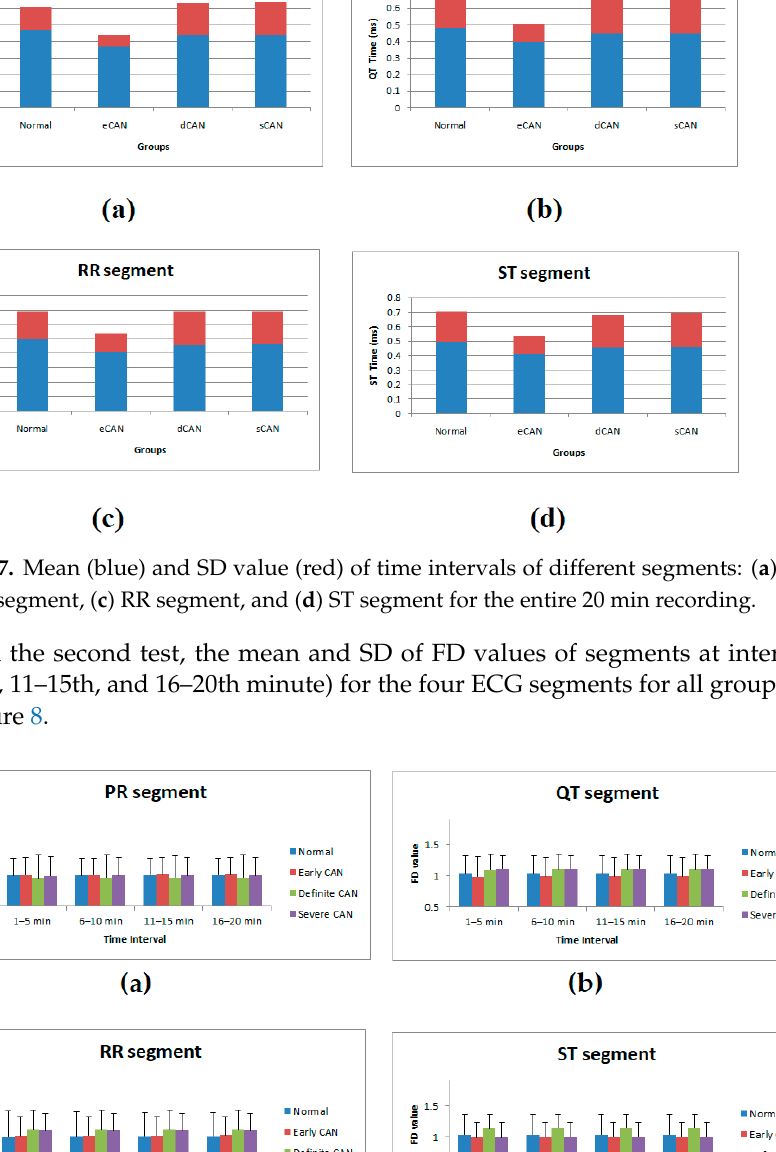
Table 4. p ‐ value from Kruskal–Wallis test. Segment